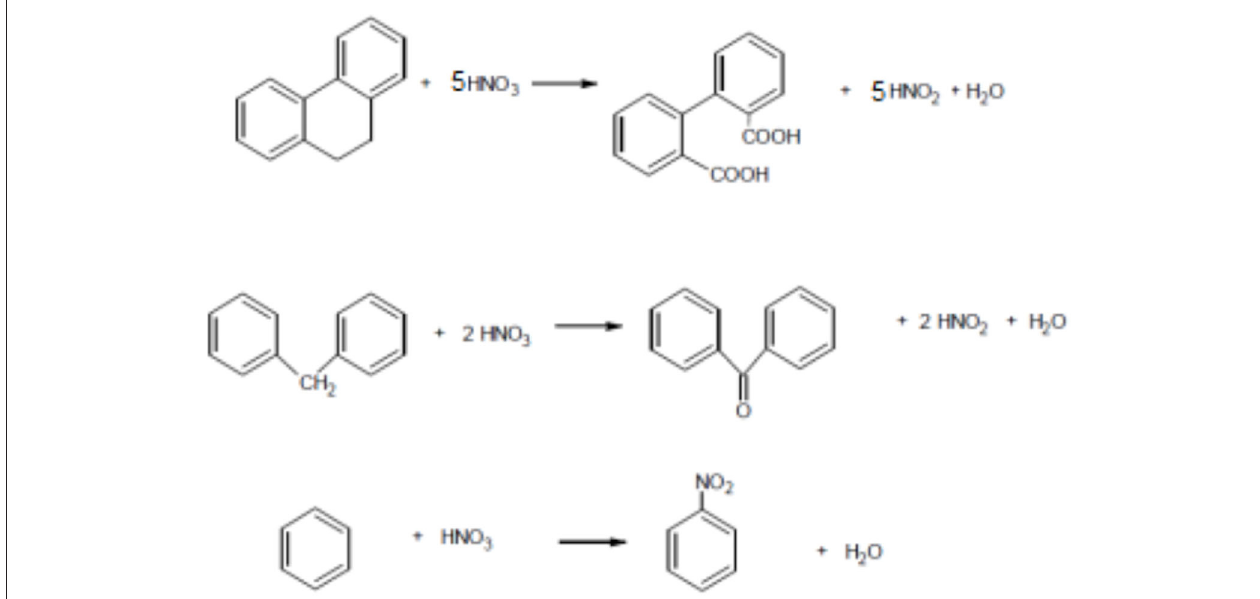
FIGURE 2 | Effect of HNO 3 treatment on the surface of an activated carbon (Chingombe et al., 2005).